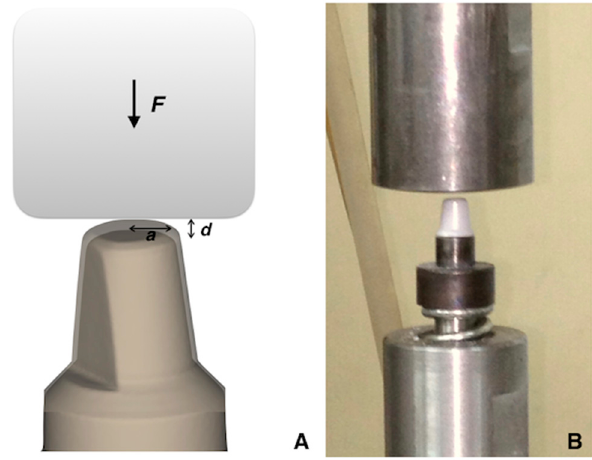
Figure 1. ( A ) Schematic of zirconia specimen. Thickness d on implant abutment indented by a cylindrical indenter with a contact area of radius a at load F. ( B ) Zirconia specimen with holder and indenter to simulate the bruxism movement by the servohydraulic testing machine.